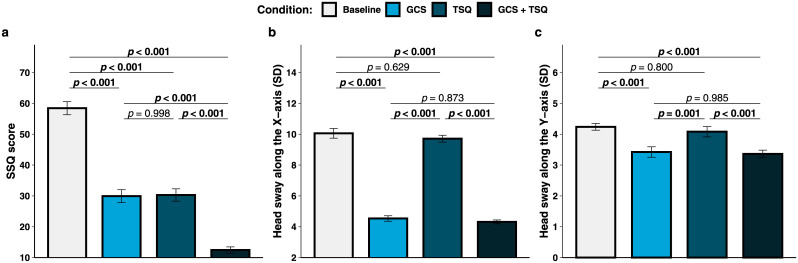
(a) SSQ score, (b) head sway along the X-axis, and (c) head sway along the Y-axis per condition.Error bars represent standard error of the mean.